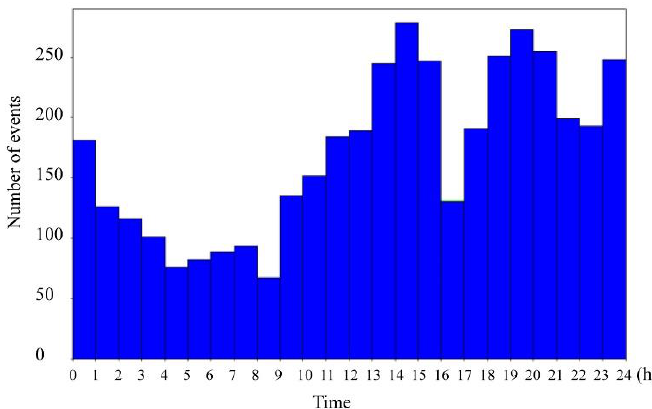
Figure 3. Daily hourly distribution of microseismic events. The l g () c t